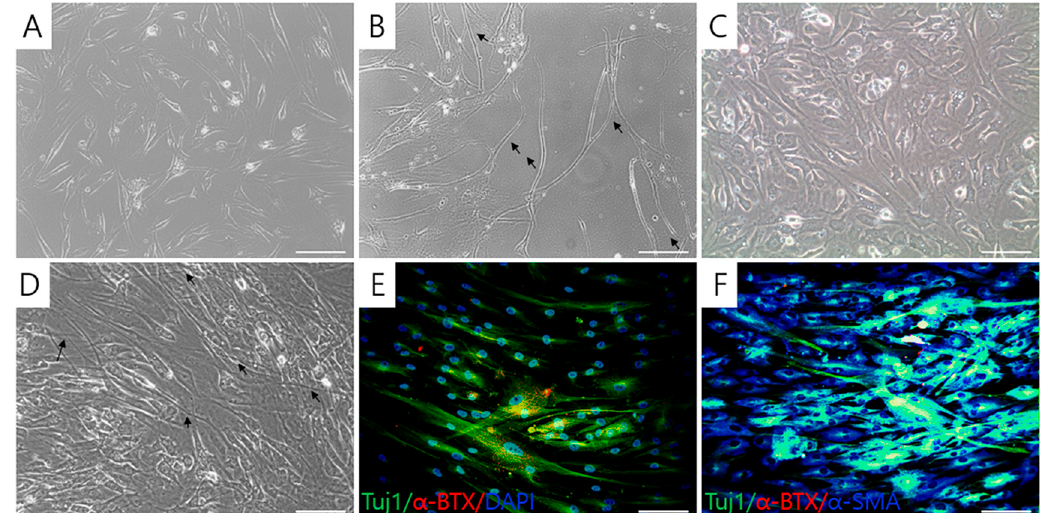
Figure 5. Formation of neuromuscular junctions in cocultures. Motor neuron-like cells (MNCs; B ) derived from tonsil-derived mesenchymal stem cells (T-MSCs; A ), and cocultured with human skeletal muscle cell (hSKMC)-derived myotubes ( C ) were observed under an inverted microscope ( × 200). After 14 days of coculture ( D ), aggregations of acetylcholine receptor (AchR) were detected by staining for DAPI (blue), immunostaining for β -III tubulin (Tuj1; green), α -smooth muscle actin ( α -SMA; blue), and labelling with Alexa555-conjugated α -bungarotoxin ( α -BTX; red) ( E , F ). Yellow fluorescence indicates the merged images for α -BTX and Tuj1, white fluorescence indicates the merged images of α -BTX, Tuj1, and α -SMA. Black arrows = T-MSC-MNC. Scale bars = 100 μ m.